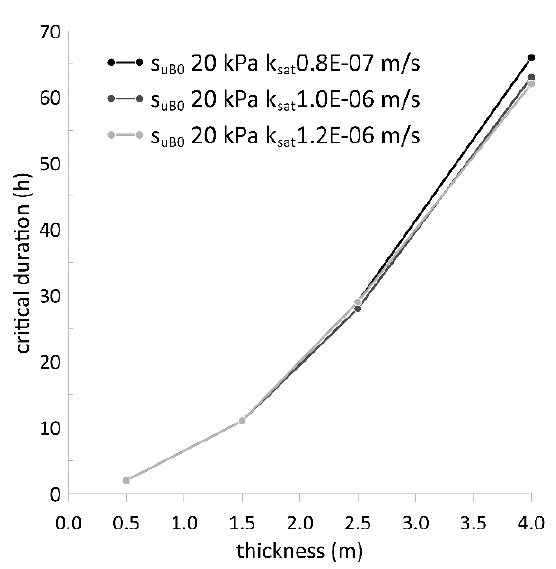
Figure 11. Results of set C analyses: critical duration against domain thickness for three different values of hydraulic conductivity at saturation (s uB0 = 20 kPa).